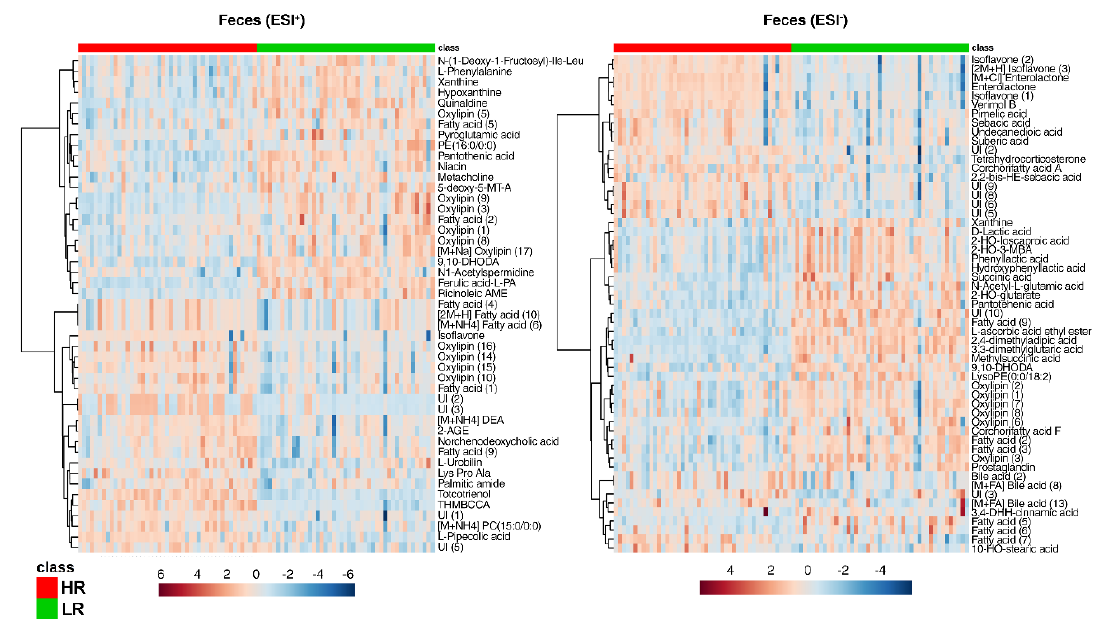
Figure 7. Heat maps of metabolites discriminating ( p < 0.05) between the HR (red class) and the LR (green class) diet in feces of Göttingen Minipigs in both positive and negative ionization mode (ESI+, ESI −